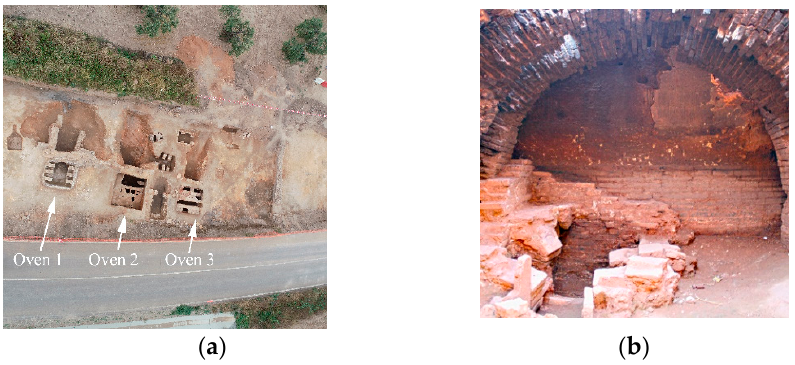
Figure 5. Photos of the archaeological site “La Matilla”: ( a ) aerial view of the exterior area; ( b ) interior of one of the three ovens located at the site.